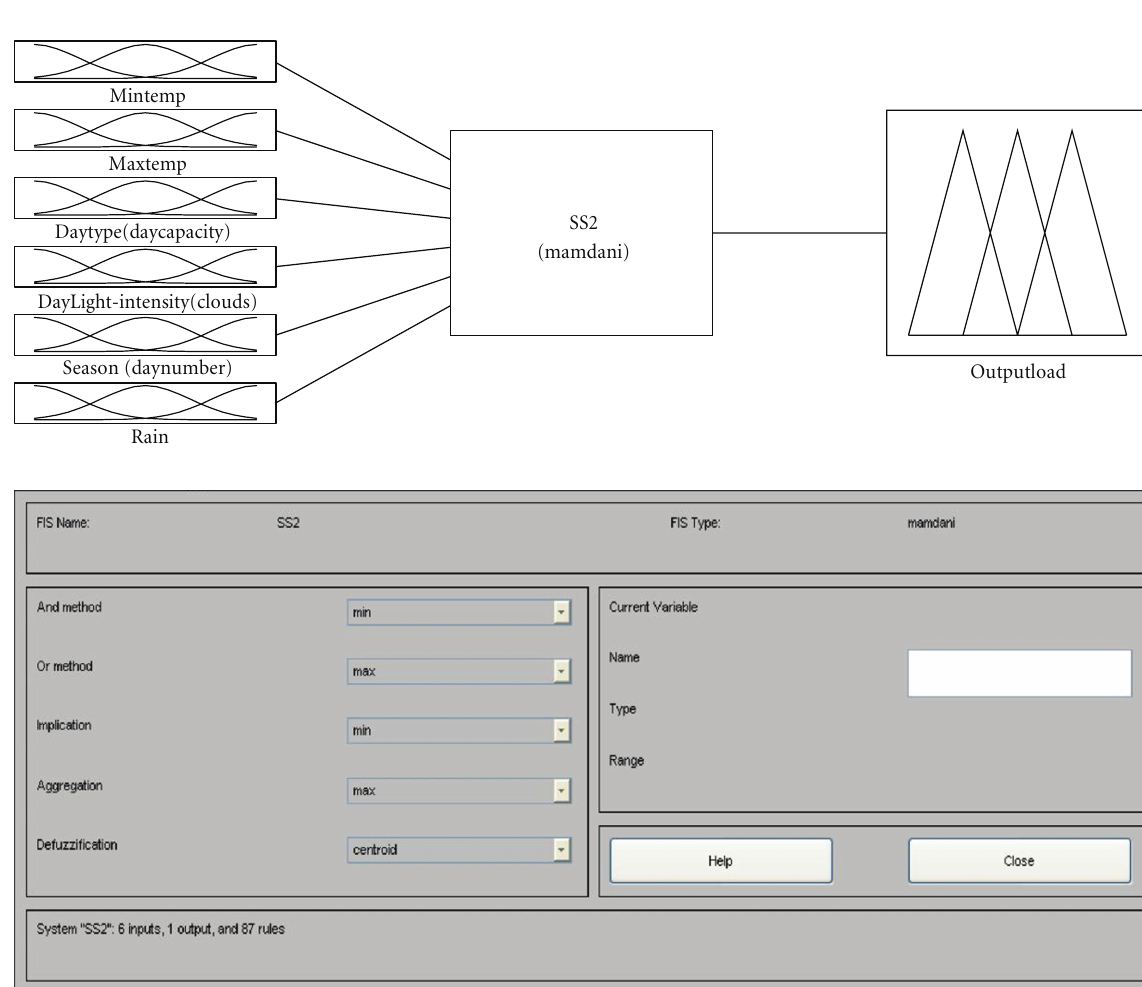
Figure 1: Flow and processing of data through fuzzy inference